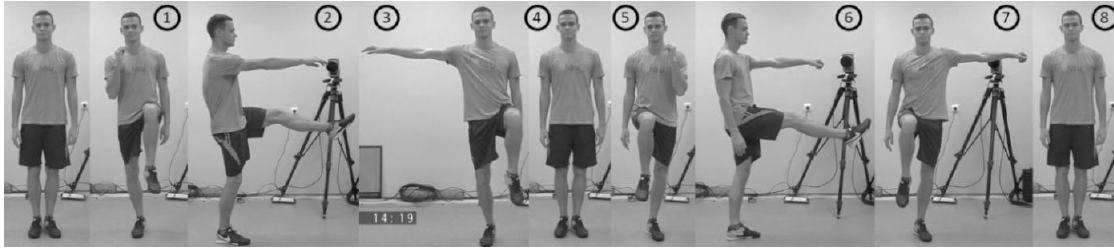
Figure 3. Motion test for the